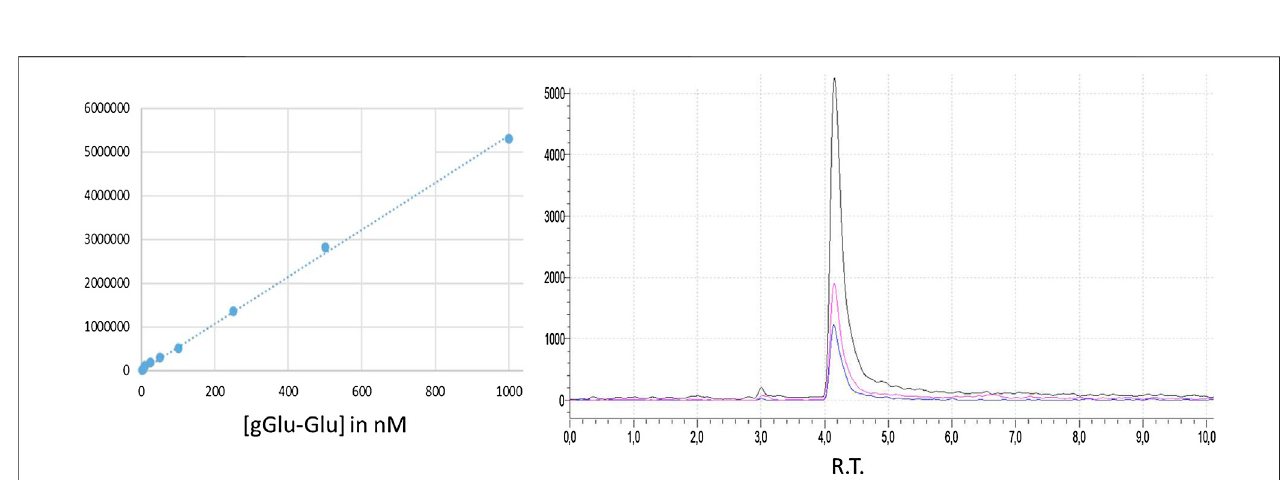
FIGURE 6 | Standard curve for γ -Glu-Glu. γ -Glu-Glu LC-MS/MS in the MRM mode showing the three transitions.